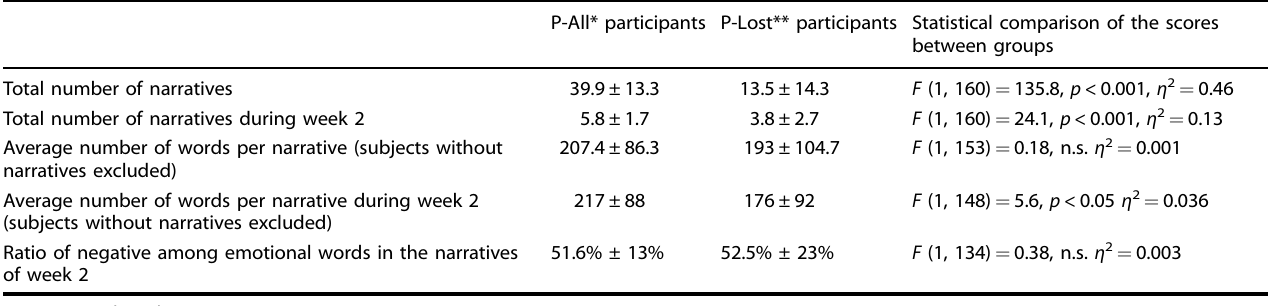
Table 4. Characteristics of narratives of P-All and P-Lost at the beginning of lockdown.